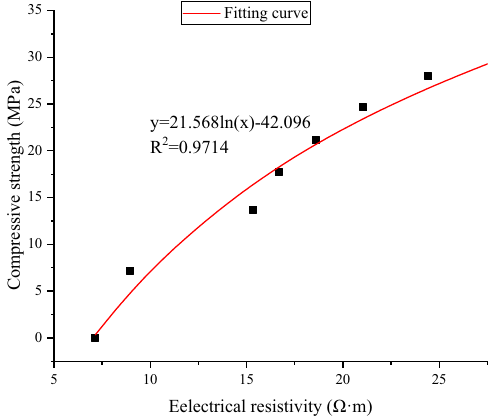
Figure 5. Relationship between the electrical resistivity and the compressive strength.